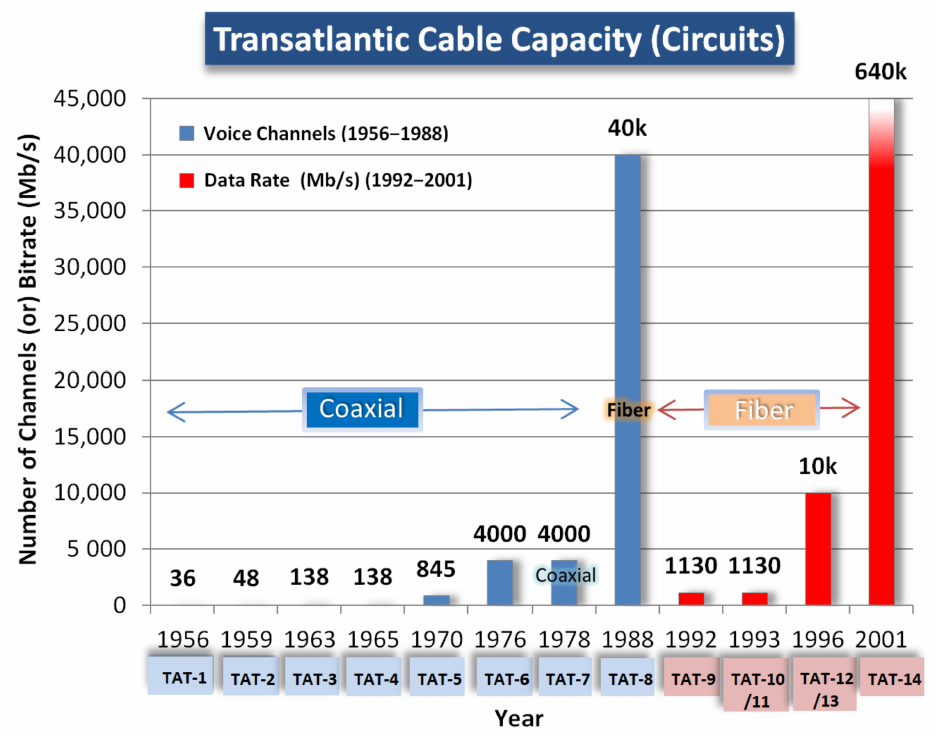
Figure 2. Transatlantic cable capacity